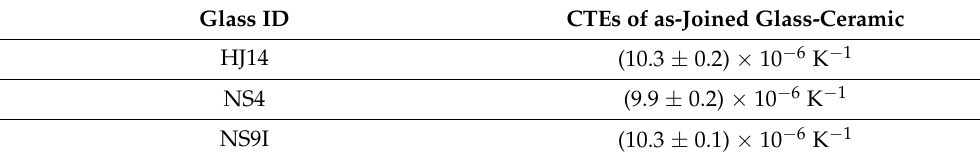
Table 3. Coefficient of thermal expansion (CTE) of the HJ14, NS4, and NS9I glass-ceramic in an as-joined condition.